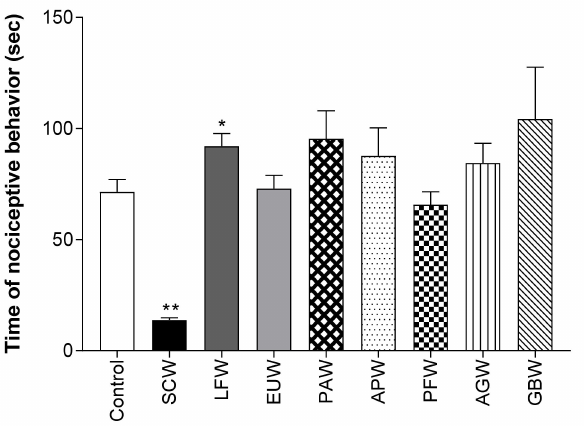
Figure 1. Antinociceptive activity of water extract from various plants in the acetic acid induced ab- dominal writhing test. Data are expressed as means ± SD; n = 8 mice per group (* p < 0.01, ** p < 0.001 vs. control group). SCW: Symplocos chinensis f. pilosa Ohwi water extract, LFW: Liquidambar formosana Hance water extract, EUW: Eucommia ulmoides water extract, PAW: Phellodendron amurense water extract, APW: Agrimonia pilosa Ledeb water extract, PFW: Perilla frutescens var. crispa water extract, AGW: Angelica gigas water extract, GBW: Ginkgo biloba water